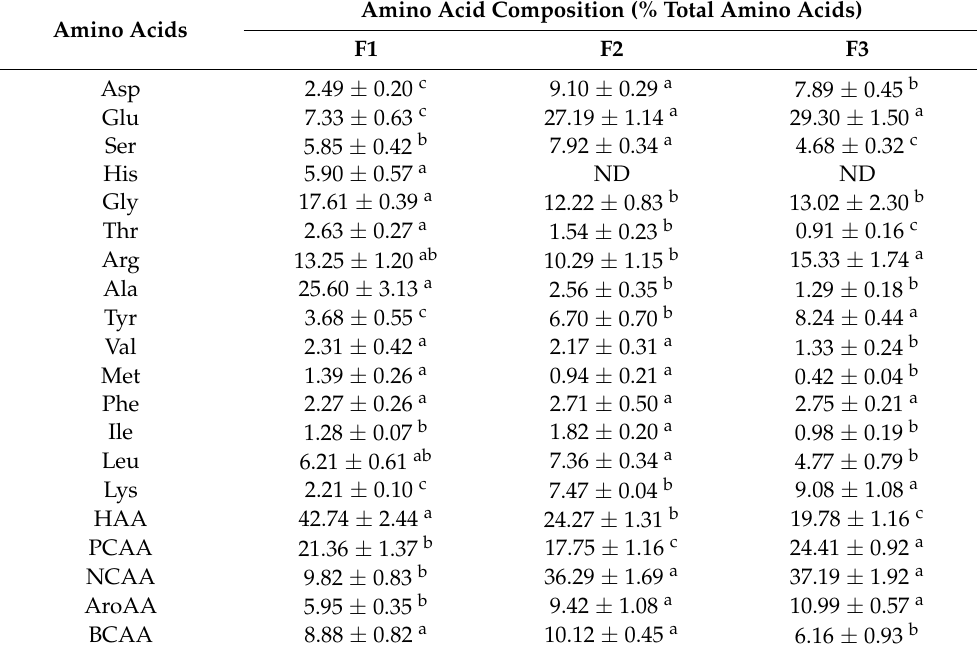
Table 3. The amino acids composition (%) of the anion exchange peptide fractions. Amino